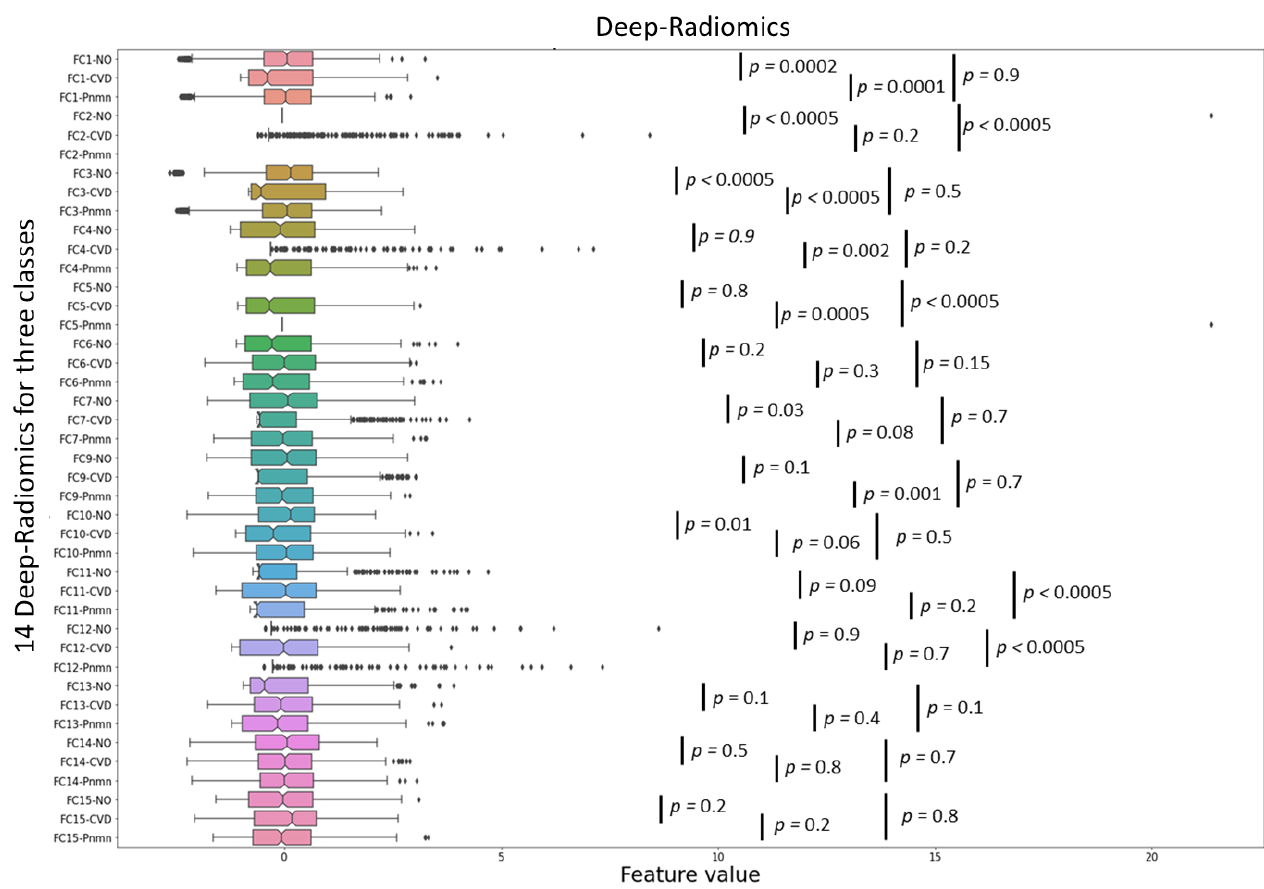
Figure 5. Similar to conventional radiomics, here classification power of 14 deep radiomic groups to categorize COVID-19 (CVD), pneumonia (Pnmn), and no finding (NO) cases with respect to ground truth are demonstrated using Kruskal–Wallis test to show the statistical significance of the classification.